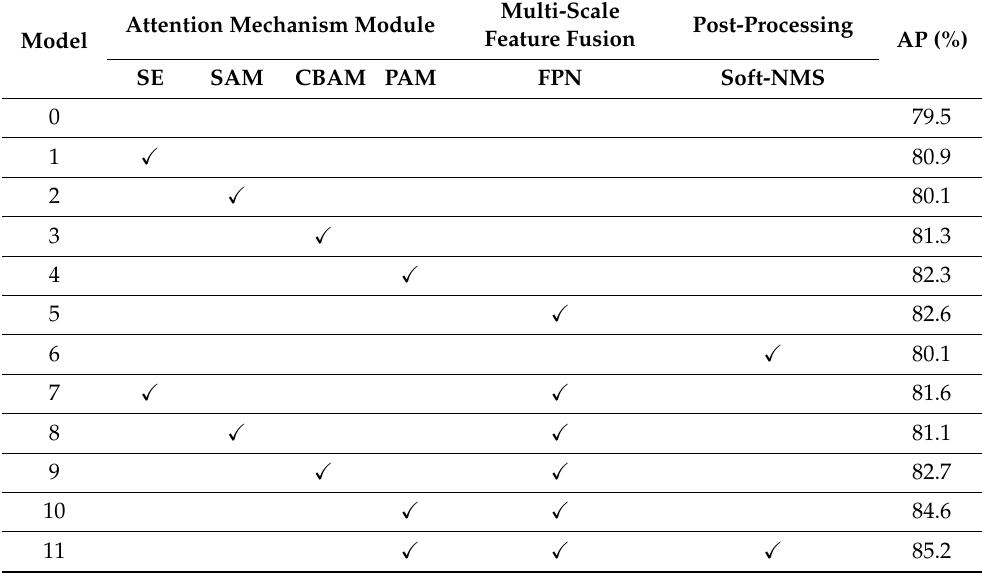
Table 4. Improved strategy ablation